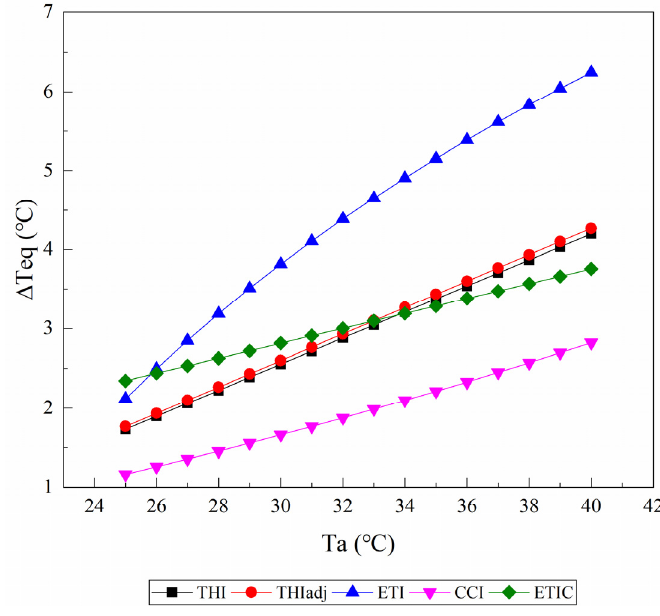
Figure 3. The changes of the equivalent ambient temperature change ( Δ Teq) caused by an increase in relative humidity from 40% to 60% as the air temperature (Ta) rises from 25 to 40 °C are reported from the temperature–humidity index (THI), adjusted THI (THIadj), equivalent temperature index (ETI), comprehensive climate index (CCI), and equivalent temperature index for dairy cattle (ETIC). Wind speed is assumed to be 0.2 m/s, and solar radiation is assumed to be 0 W/m 2 . THI2, THI3, and black globe humidity index (BGHI) are not included since they do not contain the parameter of relative humidity.